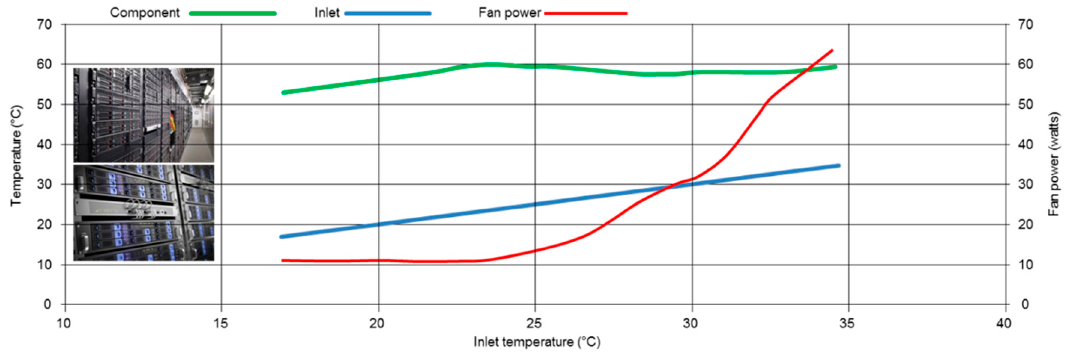
Figure 4. Internal component temperature and fan power versus inlet temperature [20].